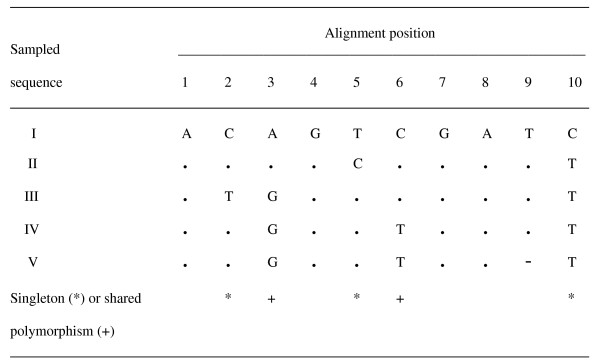
Multiple sequence alignment for five hypothetical sequences as sampled from a single population. Periods in sequences II-V refer to the same base as in I. The dash refers to a gap. Variable sites corresponding to singletons are marked with asterisks, whereas those representing shared polymorphisms are denoted with pluses.